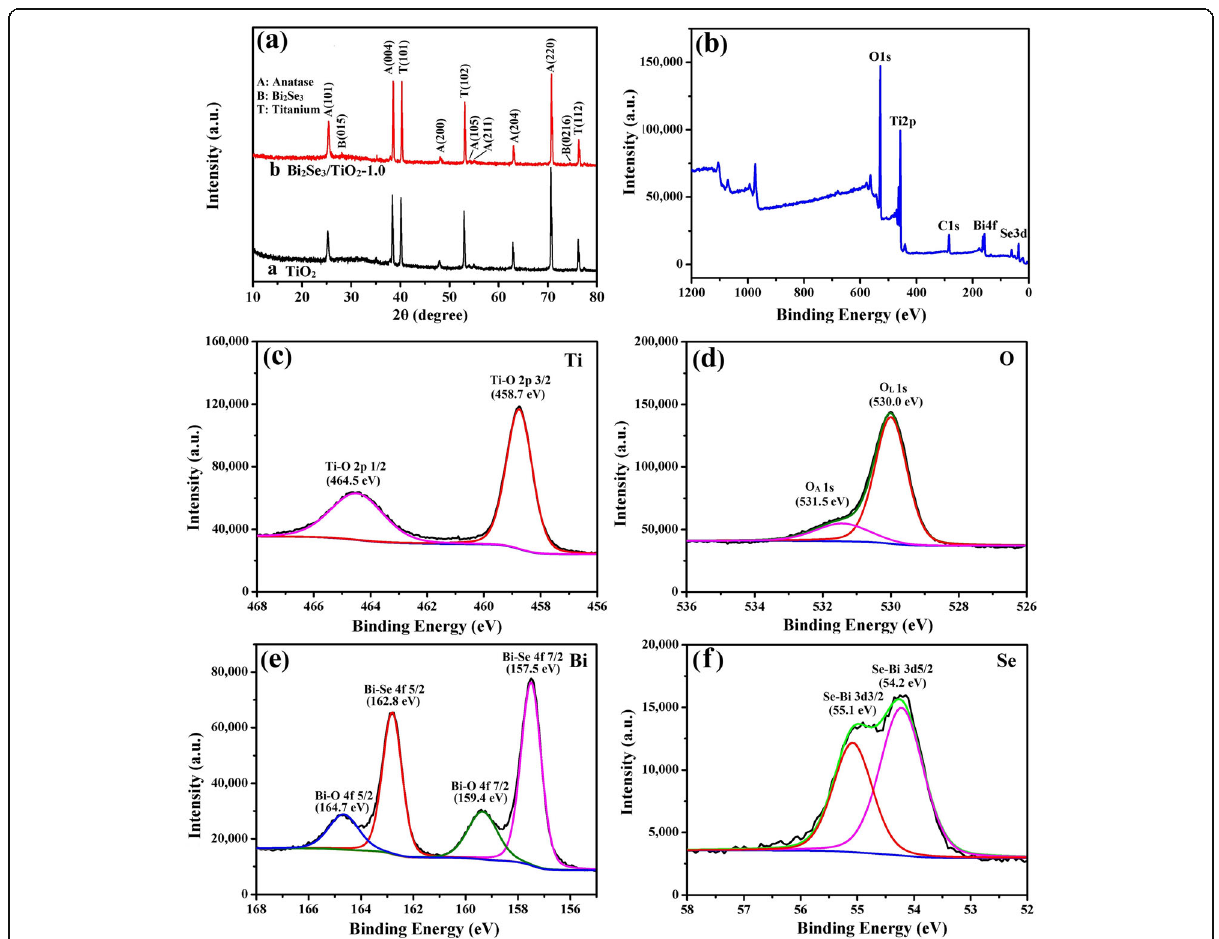
Fig. 3 a XRD patterns for pure TiO 2 and Bi 2 Se 3 /TiO 2 -1.0 nanocomposites; b the total survey spectrum, c Ti 2p, d O 1s, e Bi 4f and f Se 3d XPS spectra for Bi 2 Se 3 /TiO 2 -1.0